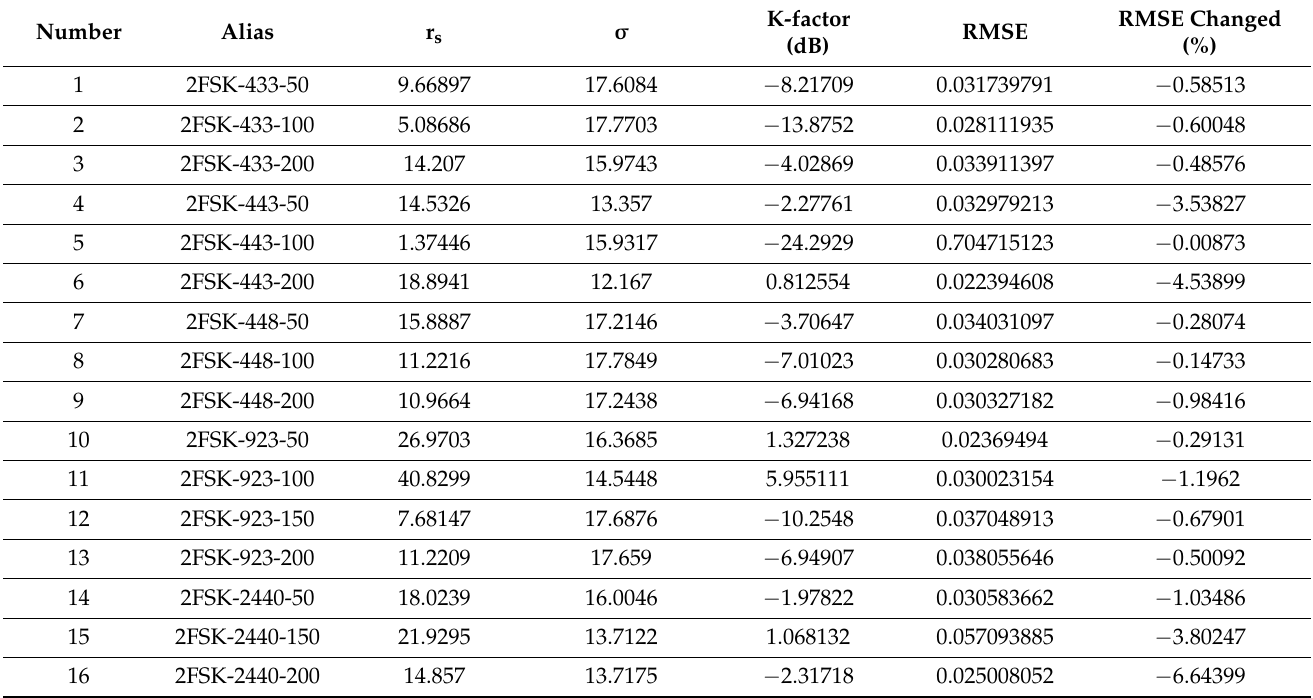
Table 5. The biased fitted Rician